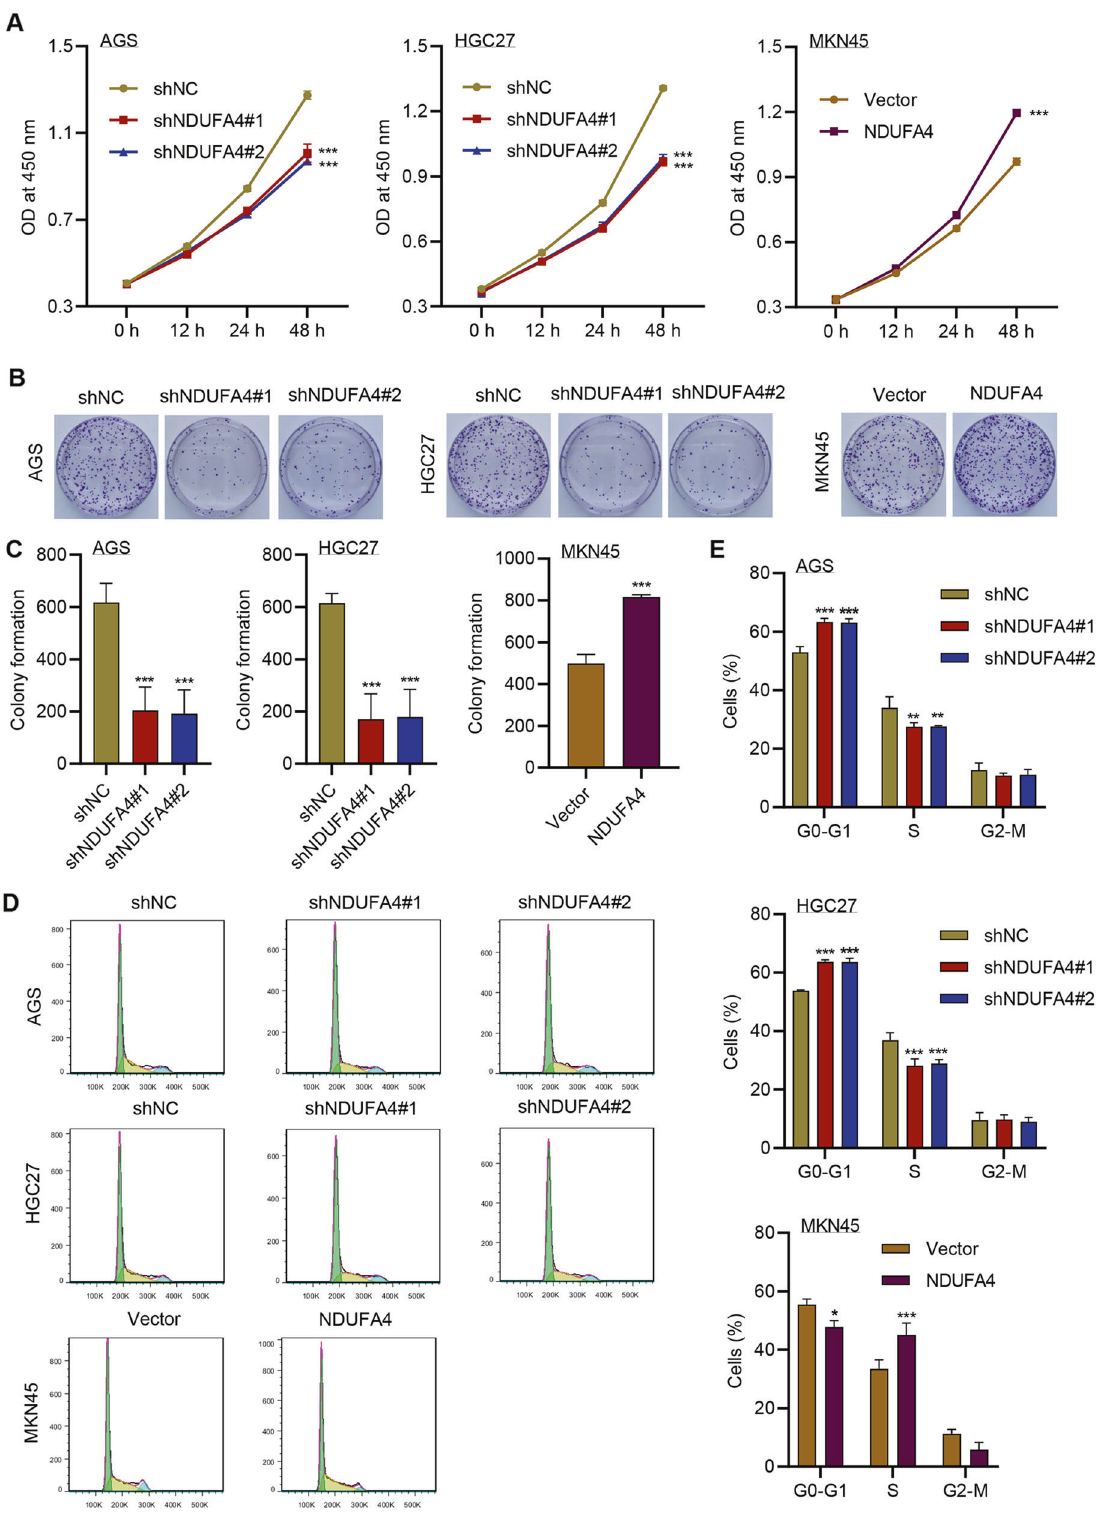
Fig. 2 NDUFA4 promoted cell proliferation and reduced cell cycle arrest and apoptosis in GC cells. A Cell viability, ( B , C ) colony formation and ( D , E ) cell cycleof AGS, HGC27 and MKN45 cells with or without NDUFA4 overexpression or knockdown. * P < 0.05, ** P < 0.01, *** P < 0.001 vs shNC or